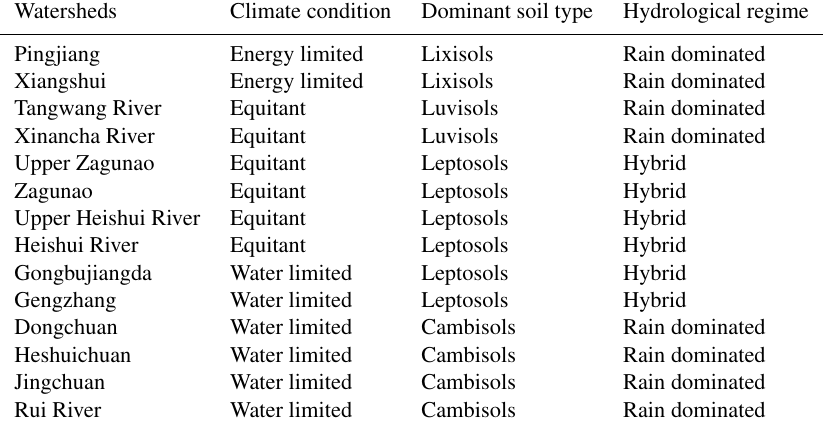
Table 2. Classification of